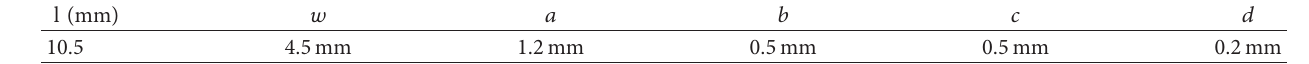
Table 1: Parameters for an interdigital LHM unit.